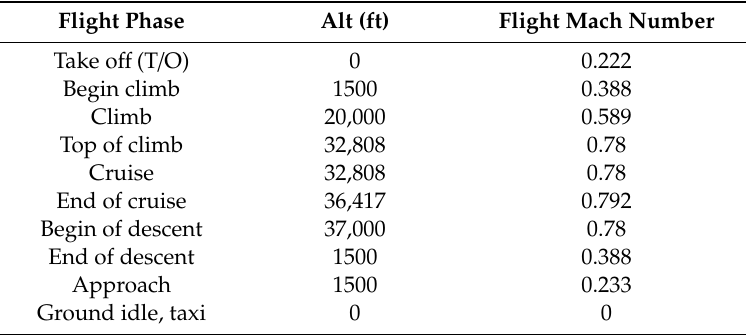
Table 3. Flight operating